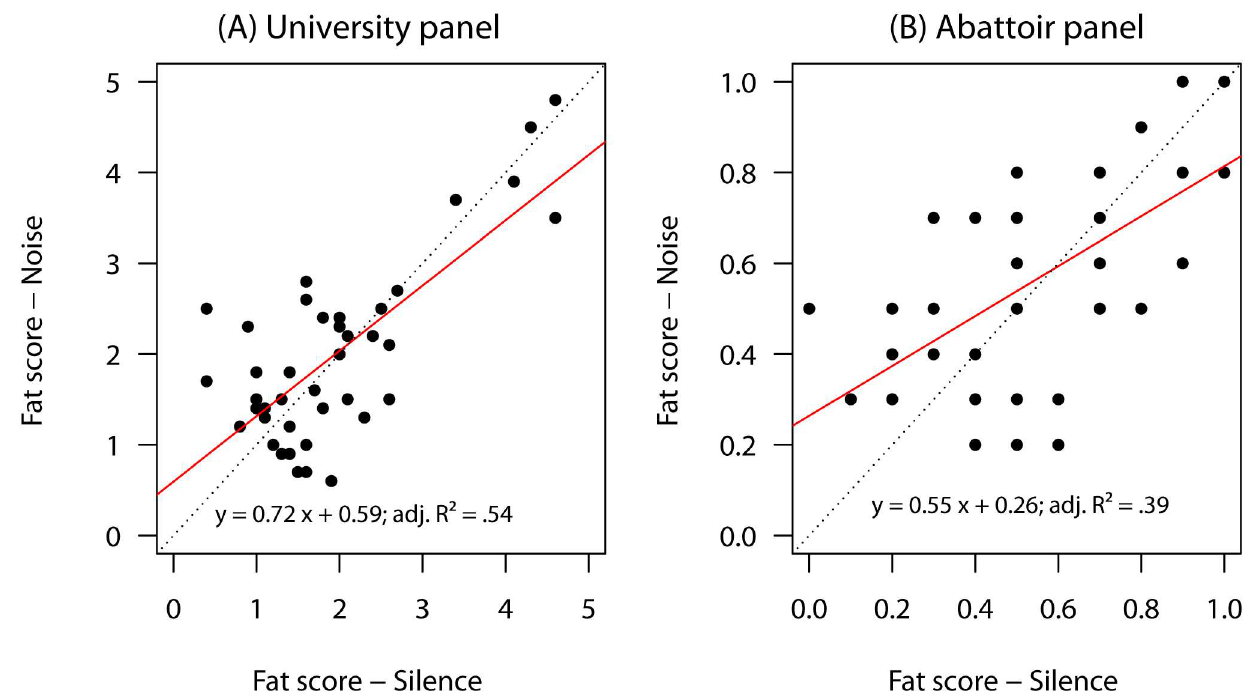
Fig 4. Comparison of averagedfat scores for each sample under noisy and silent condition. For the abattoir panelA the individualfat scores were either 0 (not tainted)or 1 (tainted). That is, the averagescore over assessors represents a probabilitythat a given sample is tainted. For the University panel U the originalscores rangedfrom 0 (standard pork fat odor) to 5 (strongly deviationfrom standard pork fat odor). Abattoir noise (70 dB) was appliedusing headphones.